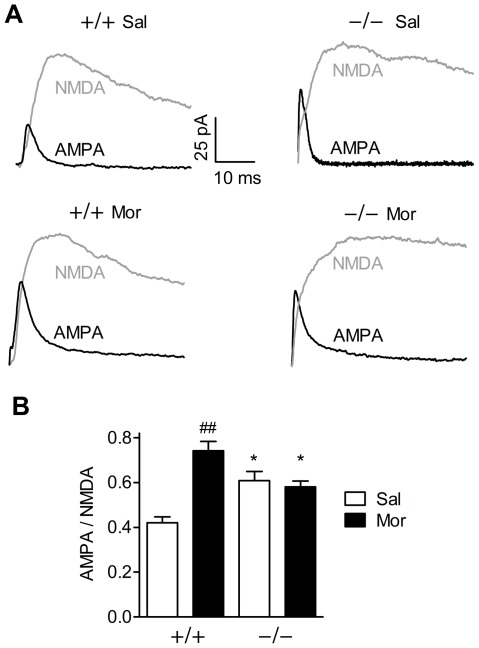
Lack of morphine-induced increase in the ventral tegmental area dopamine neuron AMPA/NMDA ratios in GluA1−/− mice.A single morphine (10 mg/kg) or saline injection was administered one day before ex vivo electrophysiological recordings from slices. (A) Representative traces displaying AMPA and NMDA receptor-mediated current components. (B) Quantification of the electrophysiological data, which is represented as means ± SEM, n = 6–11. *
p<0.05, between the genotypes; ##
p<0.01, compared to the corresponding saline control, Bonferroni test.